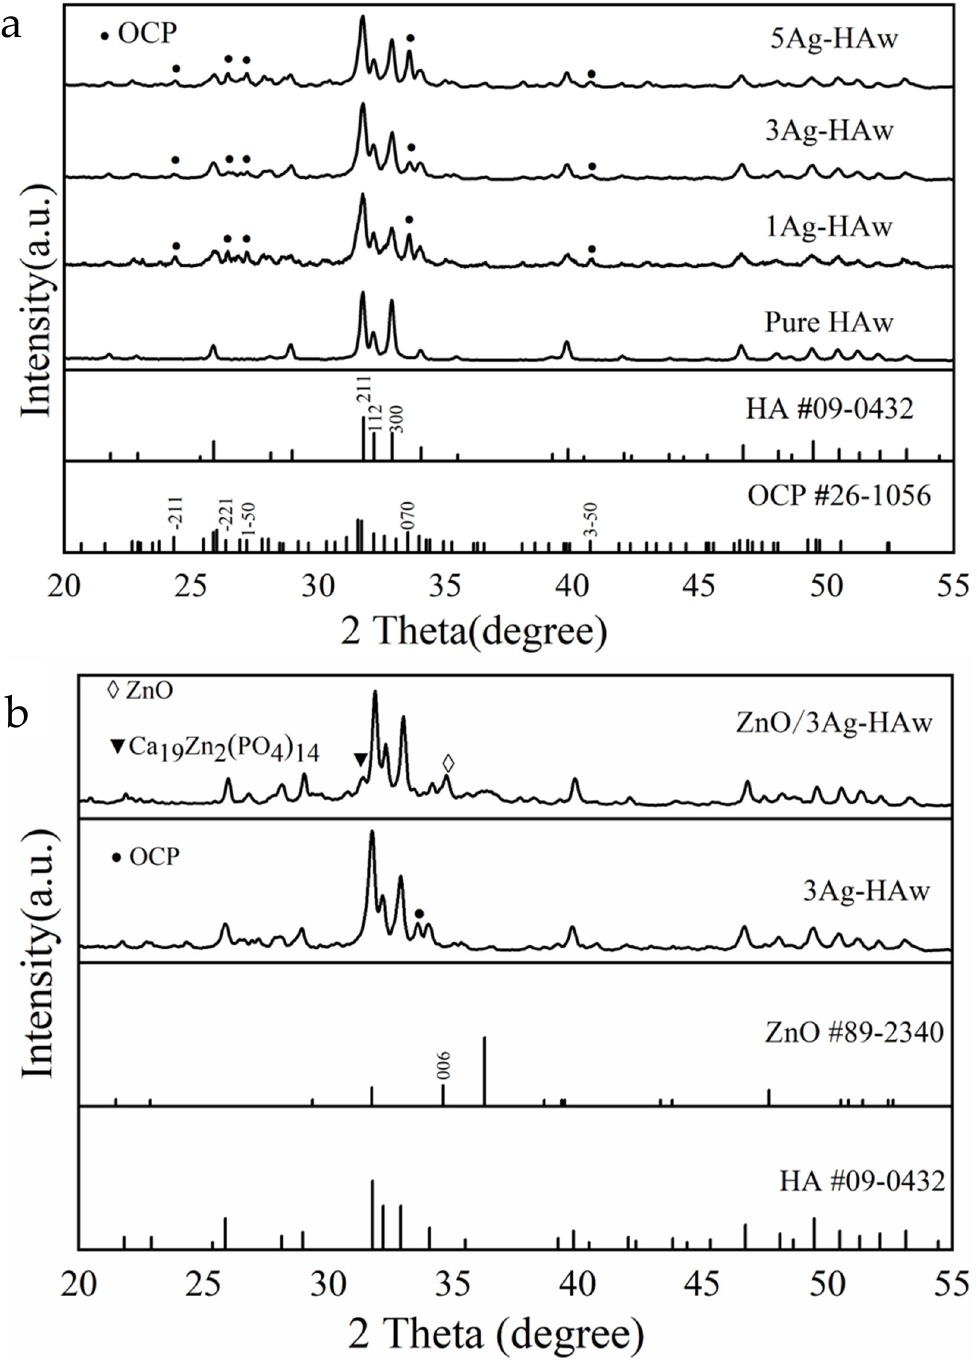
Figure 2. XRD patterns of the as-prepared whisker samples: ( a ) pure HAw and (1, 3, 5) Ag-HAw; ( b ) ZnO/3Ag-HAw and